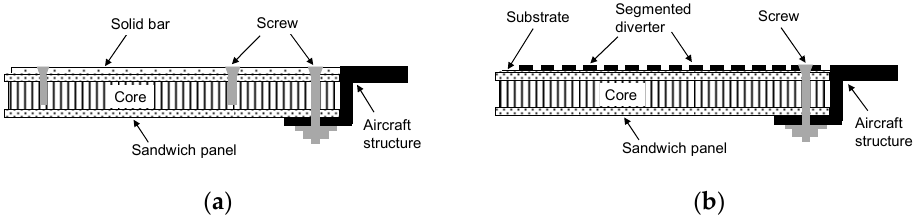
Figure 5. Schematic drawing of the design of a sandwich panel equipped with ( a ) solid and ( b ) segmented diverter strips.